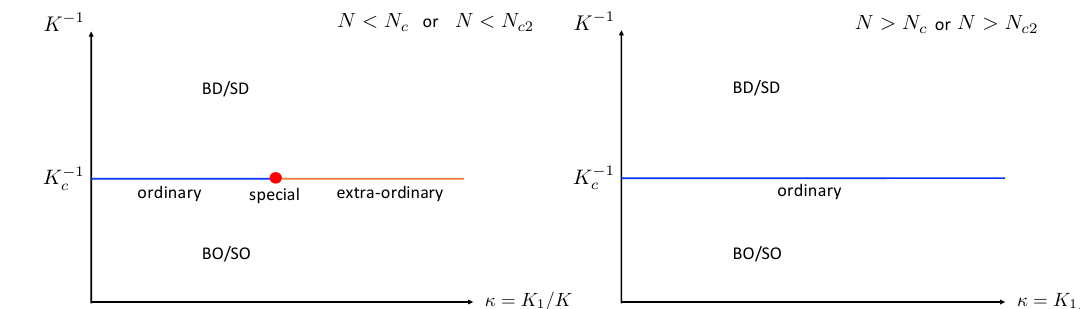
in scenario I or c